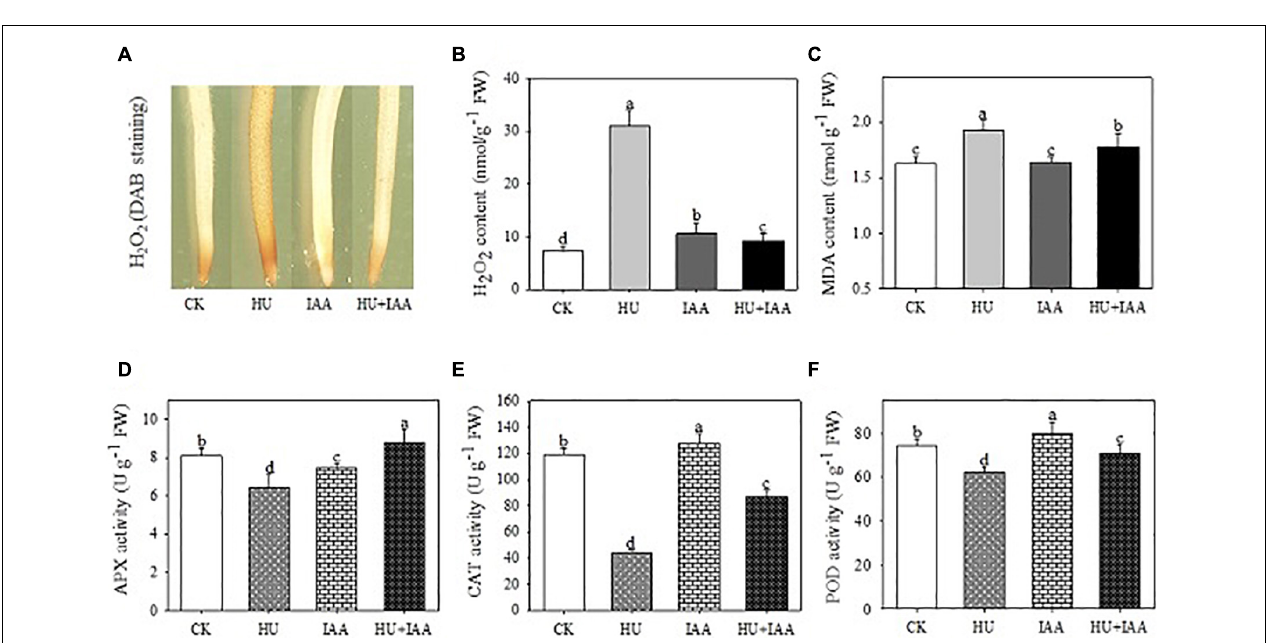
FIGURE 5 | Role of IAA treatment on HU in DNA replication and cell cycle in rice seedlings. (A) The transcript level of key cell cycle-related marker genes. (B) Confocal images of PI-stained root tips. Different letters indicate significant differences between treatments, tested by the one-way ANOVA followed by Fisher’s test ( n = 3, p < 0.05). CK, Control; HU, Hydroxyurea; IAA, indole-3-acetic acid.